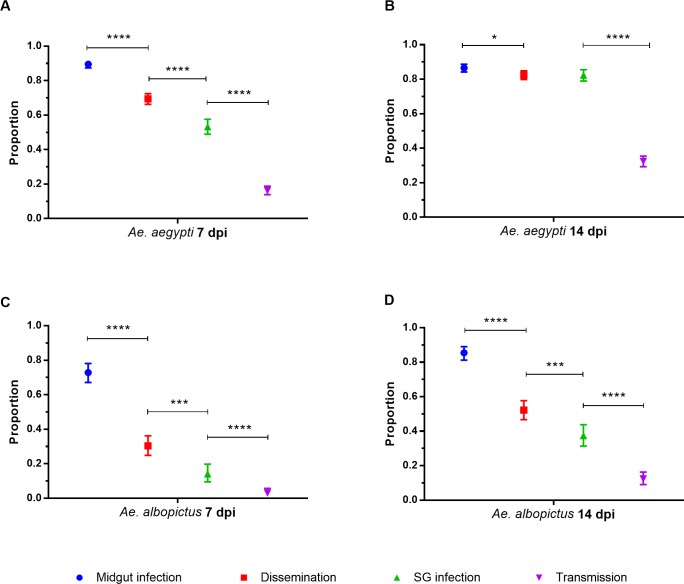
Midgut infection, dissemination, salivary gland infection and transmission rates among all Ae. aegypti and Ae. albopictus collections at 7 and 14 dpi (A and B). Error bars represent 95% HDI confidence intervals. Statistical significance is depicted as **** for p <0.0001, *** p<0.001, **p<0.01 and * p<0.05 by two-tailed Fisher’s exact test.